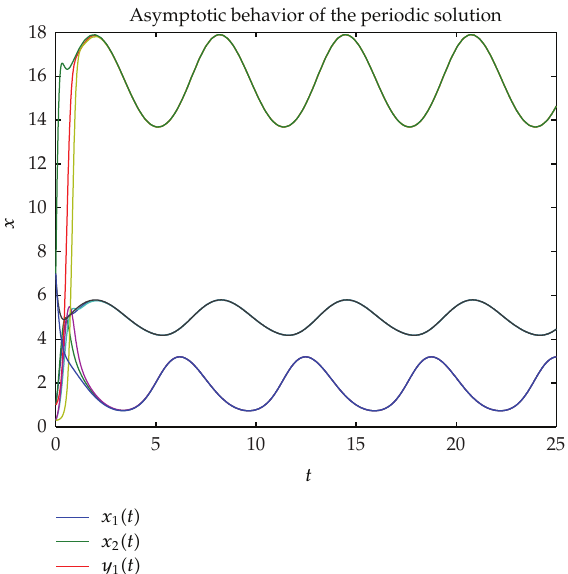
Figure 1: Asymptotic behavior of system (cid:4) 5.1 (cid:7) with initial values (cid:4) x 1 (cid:4) 0 (cid:7) ,x 2 (cid:4) 0 (cid:7) ,y 1 (cid:4) 0 (cid:7)(cid:7) (cid:8) (cid:4) 1 , 1 , 1 (cid:7) , (cid:4) 0 . 3 , 0 . 3 , 0 . 3 (cid:7) , (cid:4) 7 , 7 , 7 (cid:7) , respectively, t ∈ (cid:5) 0 , 25 (cid:6) .